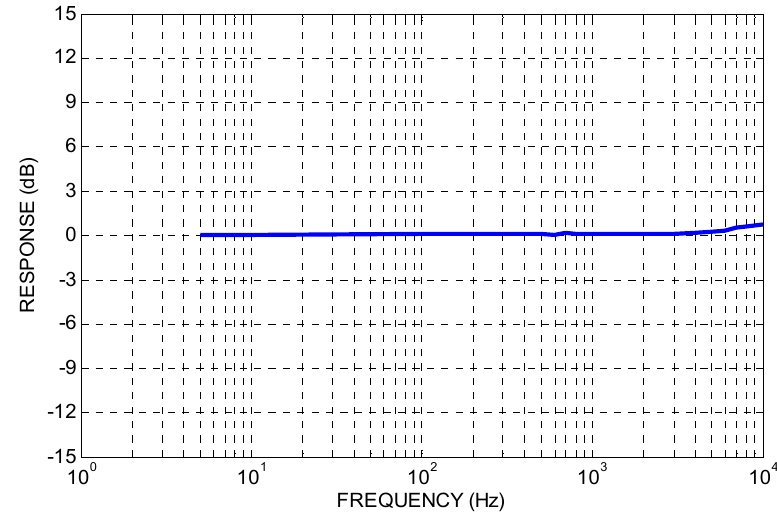
Figure 7. The frequency response of the MEMS accelerometer.